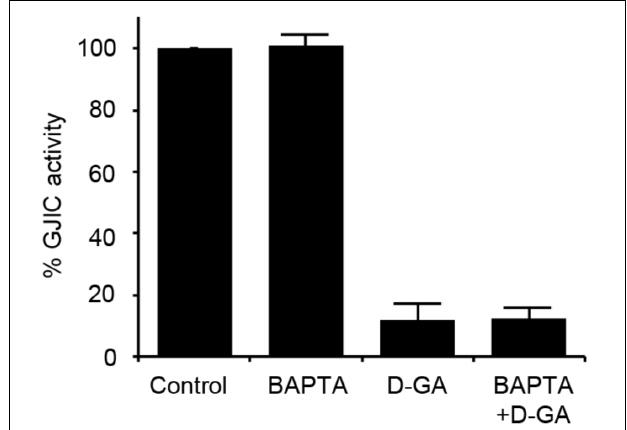
FIGURE 6 | Effect of intracellular Ca 2 + chelation on GJIC inhibition by D-GA. The LN215-I and LN215-YFP cells were mixed at a 2:1 ratio and plated in 96-well plates. After incubation for 24 h, the cells were pre-treated with vehicle or 5 µ M BAPTA-AM in 100 µ L of C-solution for 30 min. For the treatment of D-GA at 20 µ M, D-GA or its vehicle was added at 20 min of the BAPTA-AM pre-treatment period. Subsequently, the I-YFP GJIC assay was conducted. The data represent the means ± SD ( n = 3).